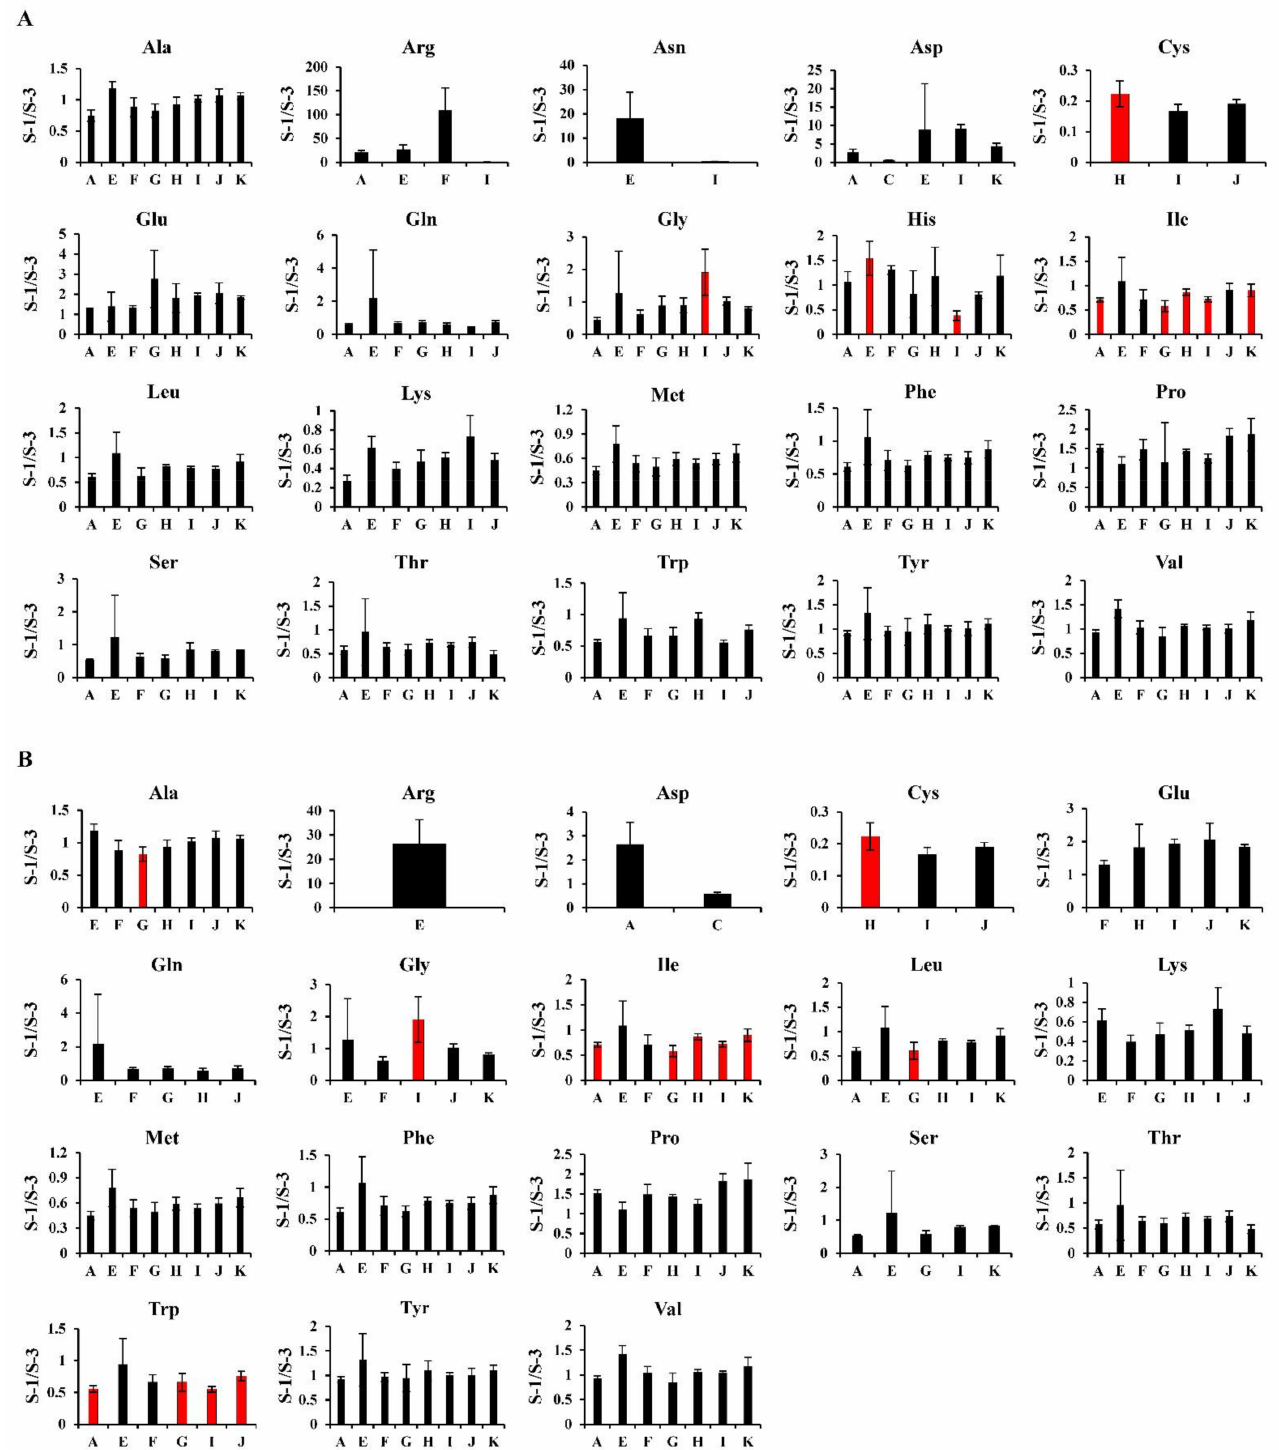
Figure 3. Inter-laboratory comparisons of the relative quantification for essential and non-essential amino acids. The relative quantification values (S-1/S-3) from the first ( A ) and second ( B ) steps for essential and non-essential amino acids are presented as the mean ± SD obtained from triplicate experiments. The red bars in each graph show the metabolites that were judged as the outliers based on one-way ANOVA ( α =